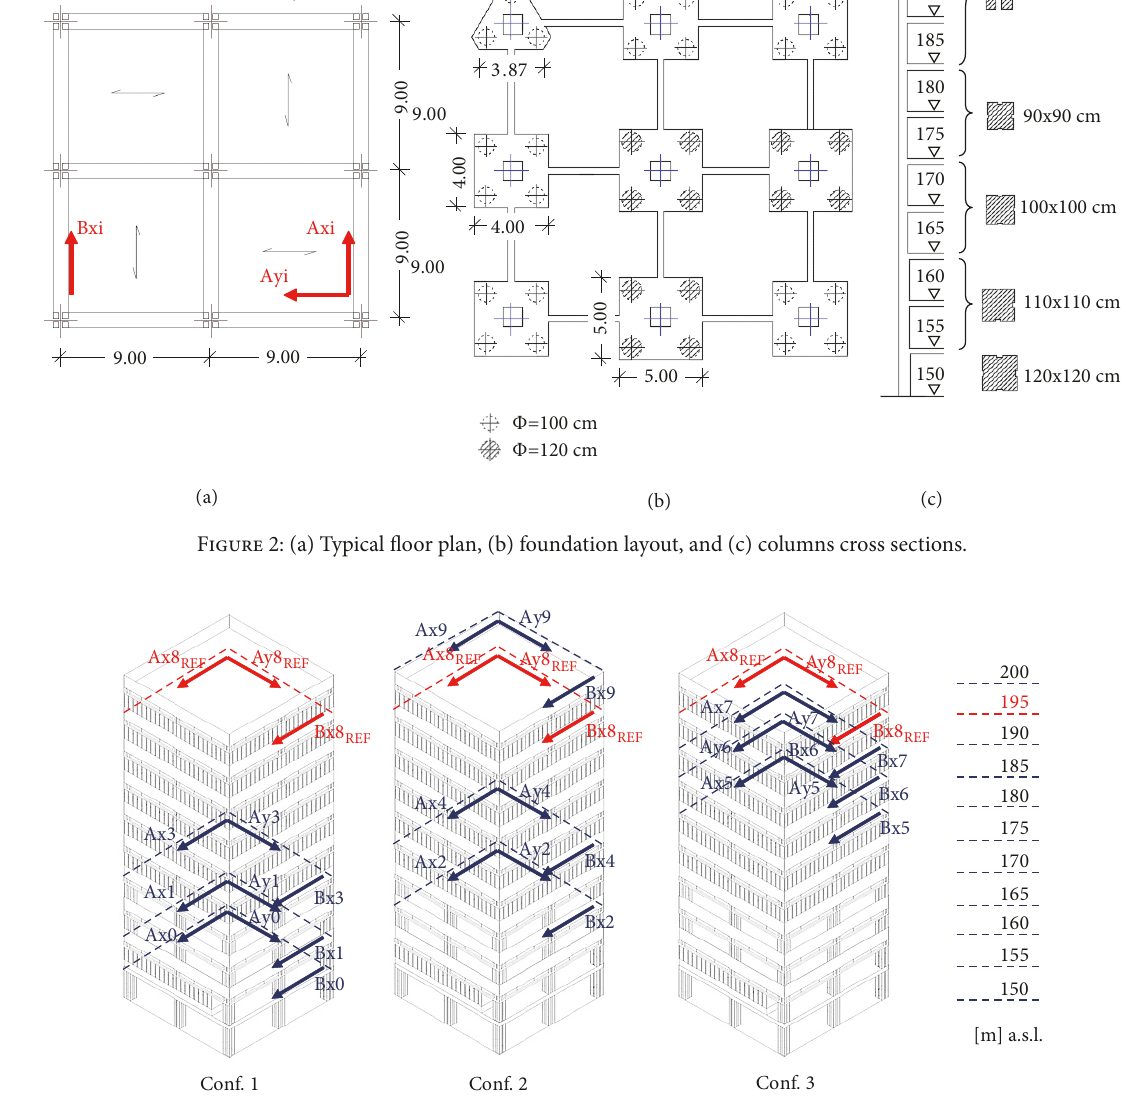
Figure 3: Configurations of